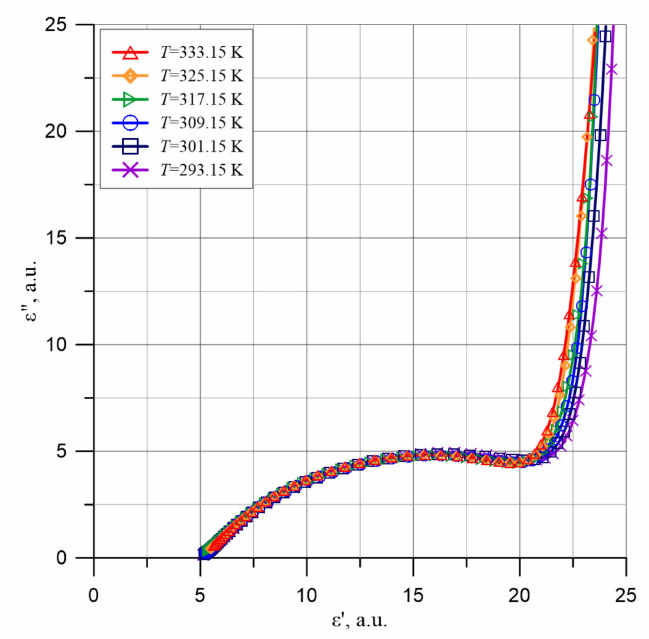
Figure 14. Cole-Cole charts in the low permittivity area ε (cid:48) for the composite of cellulose, transformer oil and water nanoparticles based on experimental data for temperatures from 293.15 to 333.15